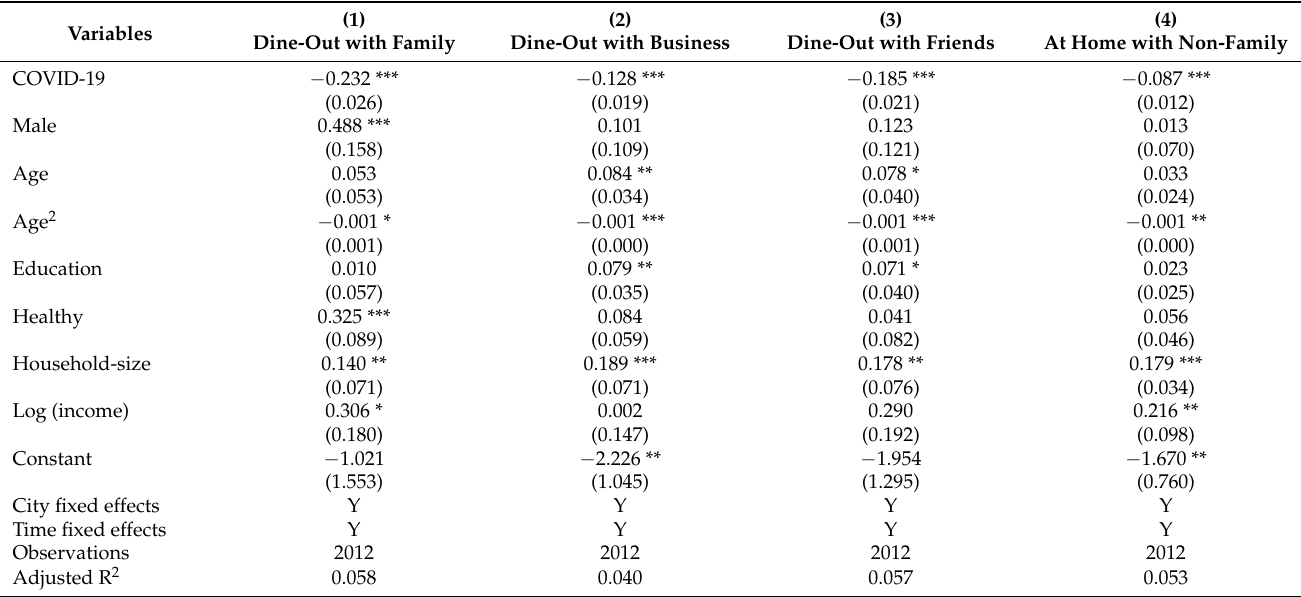
Table 4. The impact of the pandemic on the number of meal gatherings from January to February in 2019 and 2020.